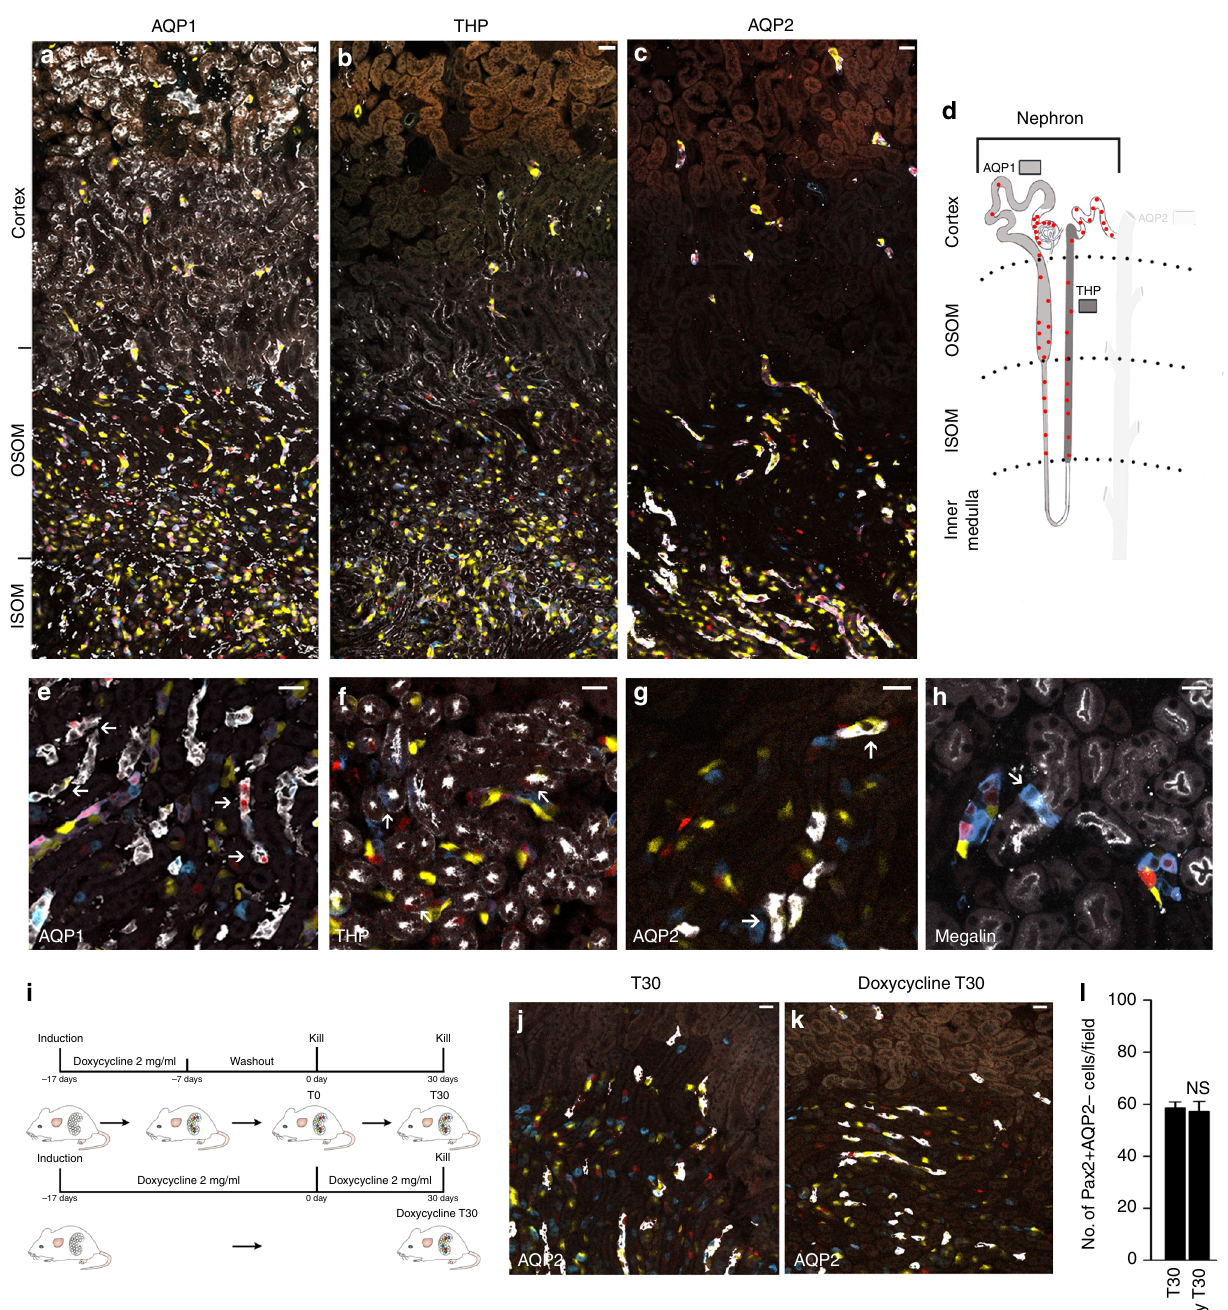
Fig. 2 Kidney tubules contain a distinct, prede fi ned Pax2 lineage-positive tubular cell subset. a – c Juxtaposed confocal images of a kidney section from cortex to inner stripe of outer medulla in adult Pax2/Confetti mice ( n = 4). Confetti reporter shows Pax2 lineage-positive single cells scattered within the proximal tubules, distal tubules and collecting ducts as demonstrated by immunolabelling for AQP1 ( a ), THP ( b ) and AQP2 ( c ), respectively (white). OSOM outer stripe of outer medulla; ISOM inner stripe of outer medulla. Scale bars 40 µ m. d Schematic localization of Pax2 − lineage-positive cells (red dots) in the proximal tubule, stained by AQP1 (light gray), in the thick ascending limb and in the distal tubule, stained by THP (dark gray), of the nephron. e – h Representative images of a kidney section in healthy Pax2/Confetti mice showing ( n = 4) the distribution of Pax2 lineage-positive cells in S3 segment of proximal tubules (AQP1 + , white) ( e ), in thick ascending limbs and distal tubules (THP + , white) ( f ), in collecting ducts (AQP2 + , white) ( g ) and in S1 – S2 segment of proximal tubules (Megalin + , white) ( h ). Scale bars 20 µ m. i Experimental schemes. j , k Representative images of a kidney section in the OSOM of Pax2/Confetti mice showing Pax2 + AQP2 − cells after 30 days of washout (T30, n = 5) ( j ) and after 30 days with doxycycline (doxycycline T30, n = 4) ( k ). AQP2 staining is white. l Number of Pax2 + AQP2 − cells in OSOM of Pax2/Confetti mice at T30 ( n = 5) and after 30 days with doxycycline (doxy T30, n = 4). Mann – Whitney test NS. Data are mean ± SEM. Scale bars 20 µ m. Pax2 + = Pax2 lineage-positive